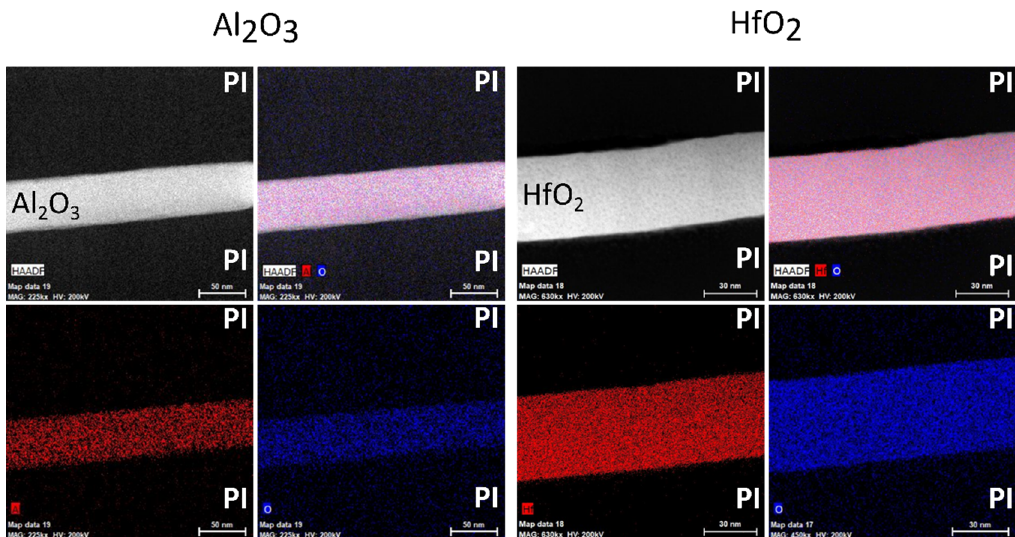
Figure 6. HAADF-STEM and EDS maps of PI/Al 2 O 3 /PI and PI/HfO 2 /PI cross-sections. The scale bar on the Al 2 O 3 images corresponds to 50 nm and the scale bar on the HfO 2 images to 30 nm. Blue represents oxygen. Red represents Al in the Al 2 O 3 EDS maps and Hf in the HfO 2 EDS maps.